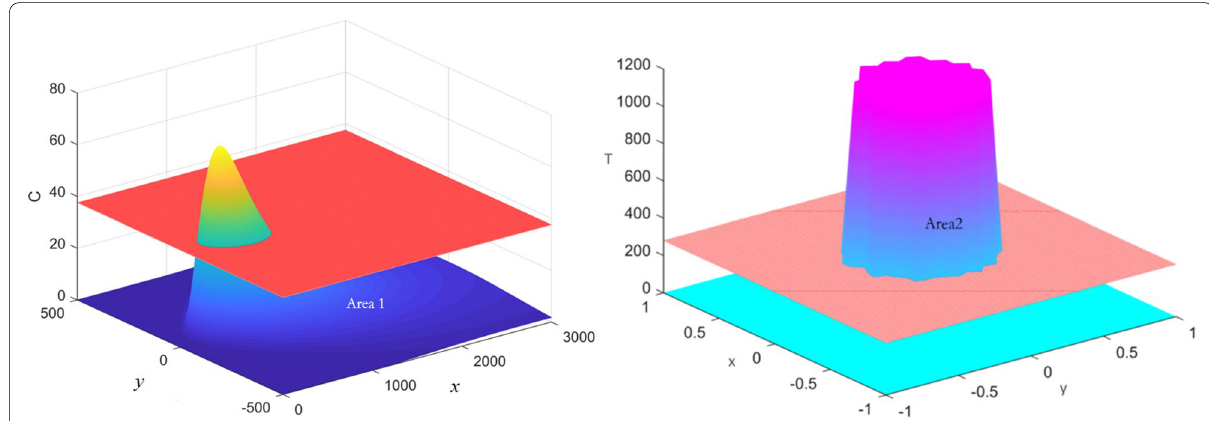
Fig. 6 Machining plane combustion